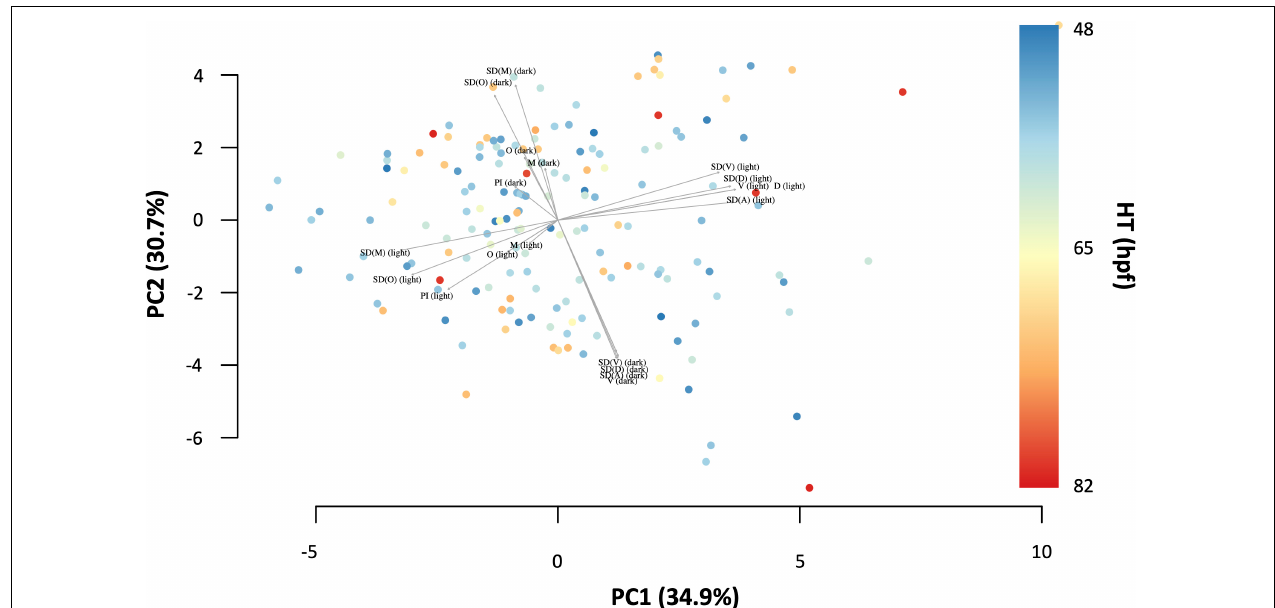
FIGURE 4 | Principal component plot with the first two principal components of the explanatory variables for swimming behaviour during the light dark challenge assay: distance moved (D), velocity (V), acceleration (A), angular velocity ( (cid:127) ), meandering (M), and percentage immobility (PI) displaying 65.6% of the total variance. Hatching time (HT) is represented by